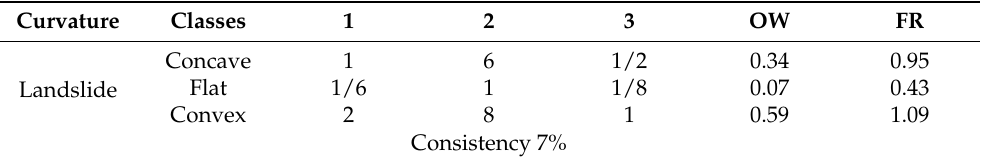
Table 8. AHP matrices and OWs for the curvature causative factor